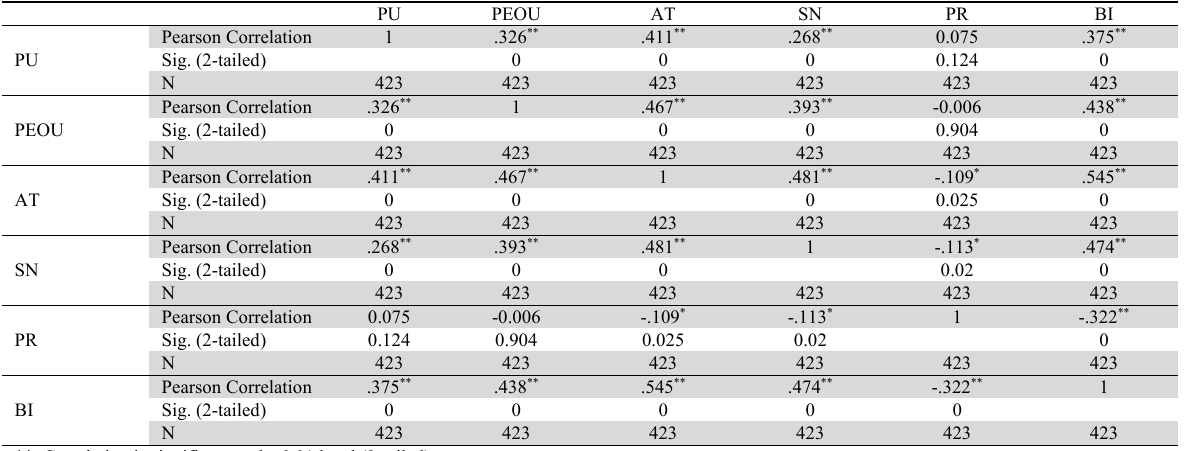
Correlations Matrix